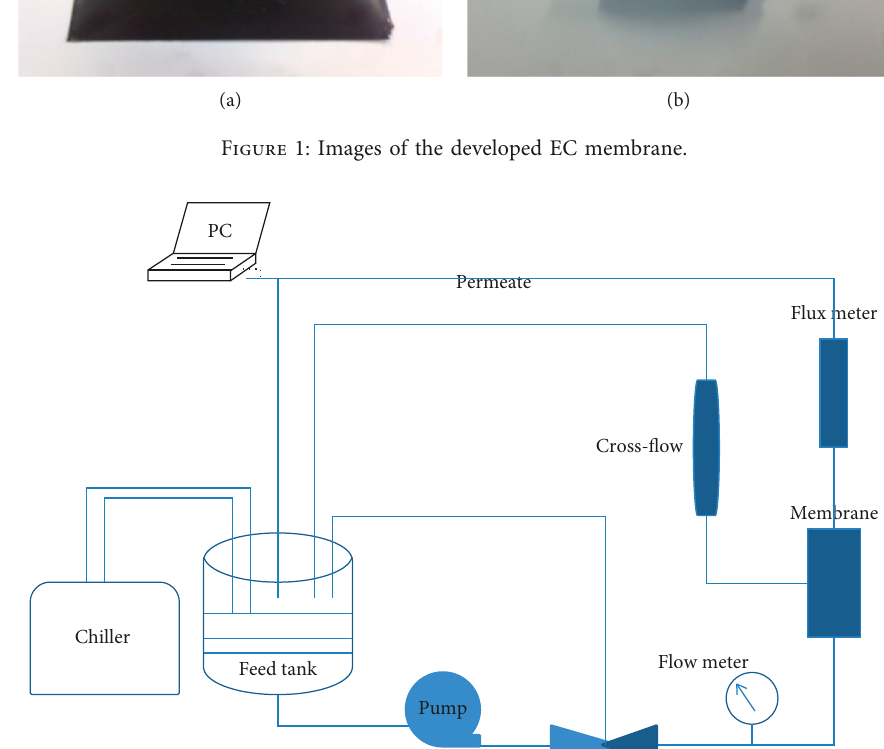
Figure 2: Schematic illustration of forward cross-flow filtration